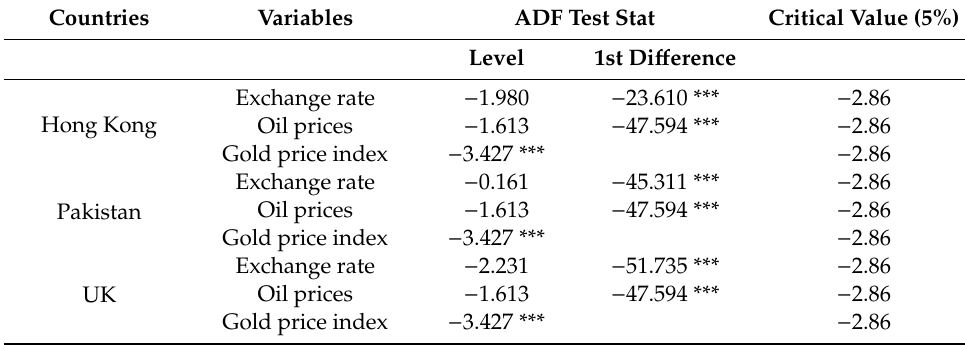
Table 4. Augmented Dickey–Fuller (ADF) unit root